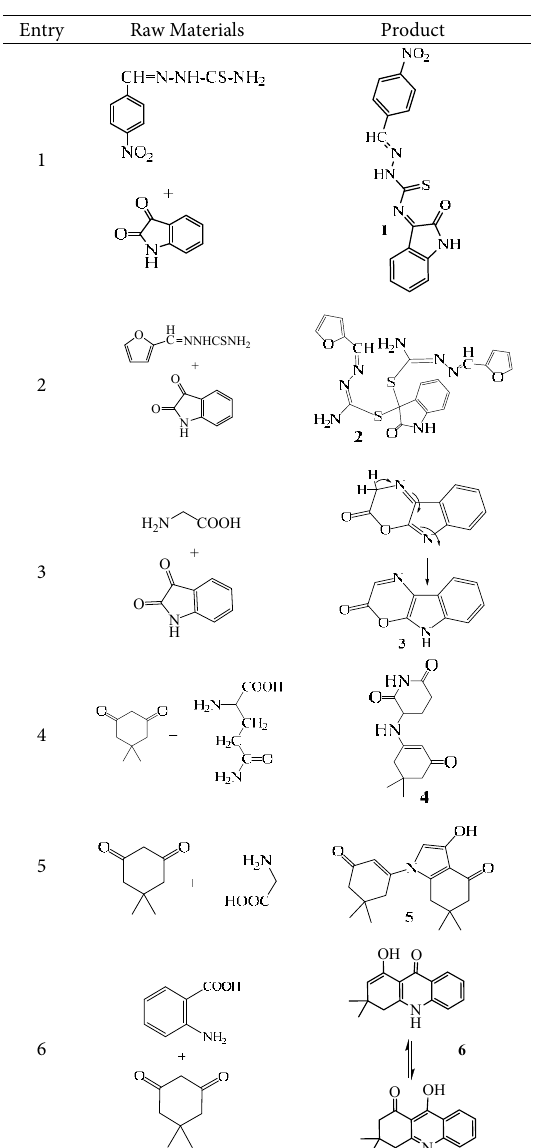
Table 2. Synthesis of some acridine and indole derivatives using (MWCNTs)-COOH/La 2 O